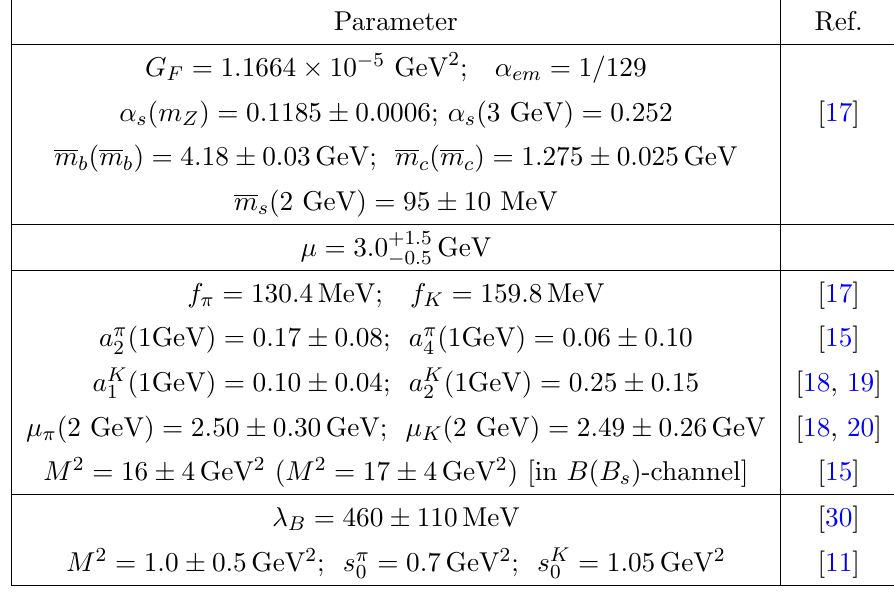
Table 1 . Input parameters used in the numerical